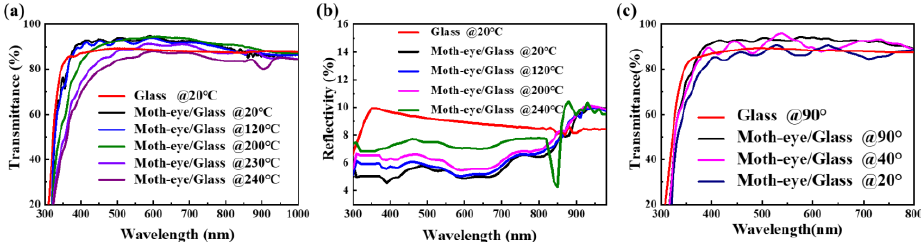
Figure 4. ( a ) Transmittance and ( b ) reflectance spectra of moth-eye/glass and glass at different temperatures when the light incident angle is 90°; ( c ) Transmittance spectra of moth-eye/glass and glass at incident angles of 20°, 40°, and 90°.